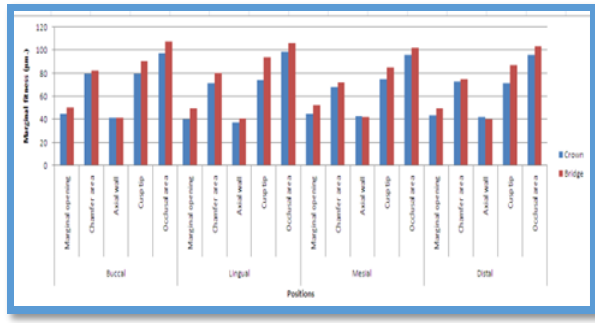
Figure 6: bar- chart showing the differences between the premolar single crowns and premolar within the bridge in marginal and internal